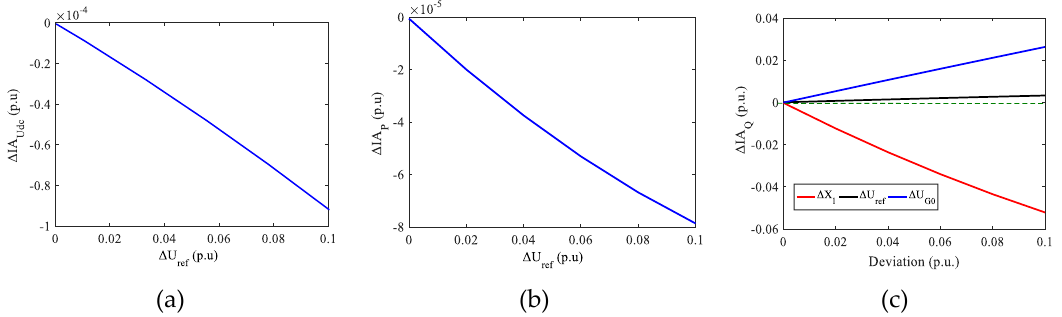
Figure 13. Initial amplitude( IA )deviation curves of ( a ) GVSC DC voltage, ( b ) active power, and ( c ) reactive power.